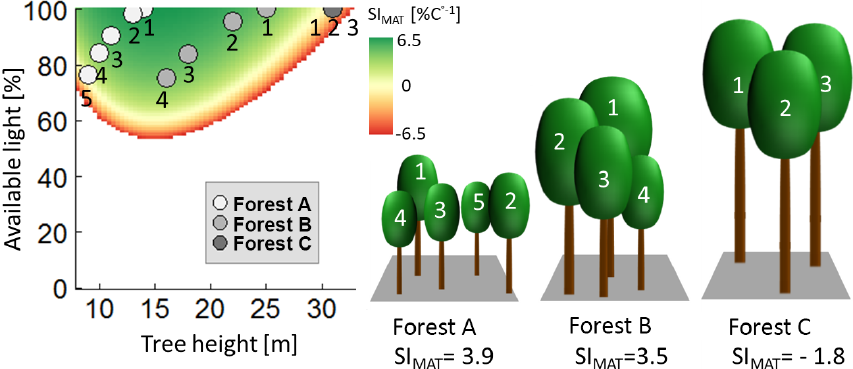
Figure 6. Analysis of the sensitivity index of AWP against mean annual temperature (SI MAT ) values of single trees within three different forests. The diagram shows the calculated SI MAT value of individual trees for every combination of tree height and available light (for Pinus sylvestris between SI MAT levels of 6.5 and − 6.5; other species show similar patterns). The dots indicate the different trees of the three forest examples. The white dots belong to trees with the corresponding number of forest A, grey dots belong to the trees of forest B, and dark grey dots belong to forest C. Note that, in the case of forest C, all trees have the same height and the same light, so that all three dots are at the same place in the